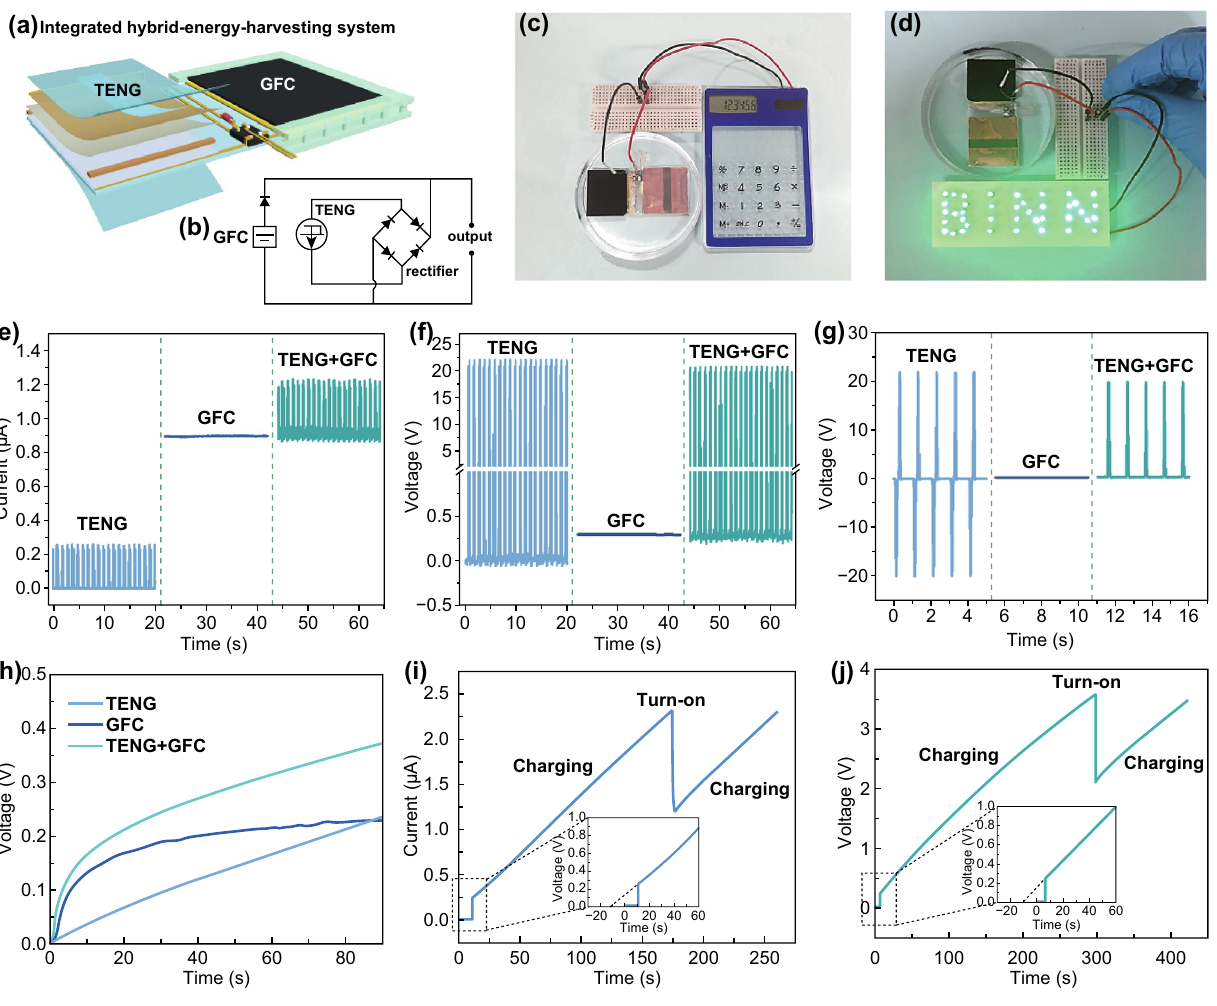
Fig. 5 a Structure diagram and b circuit diagram of the integrated HEHS for multiple energy harvesting. Demonstration of powering c a cal‑ culator and d a green BINN pattern by the HEHS in PBS/glucose solution. e Output current of rectified TENG, GFC and their hybrid device. f Output voltage of rectified TENG, GFC and their hybrid device. g Output voltage of unrectified TENG, GFC, and their hybrid device (i.e., HEHS). h Charging curves by rectified TENG, GFC, and their hybrid device (i.e., HEHS). Charging/discharging curves of powering i a calcula‑ tor and j a green BINN